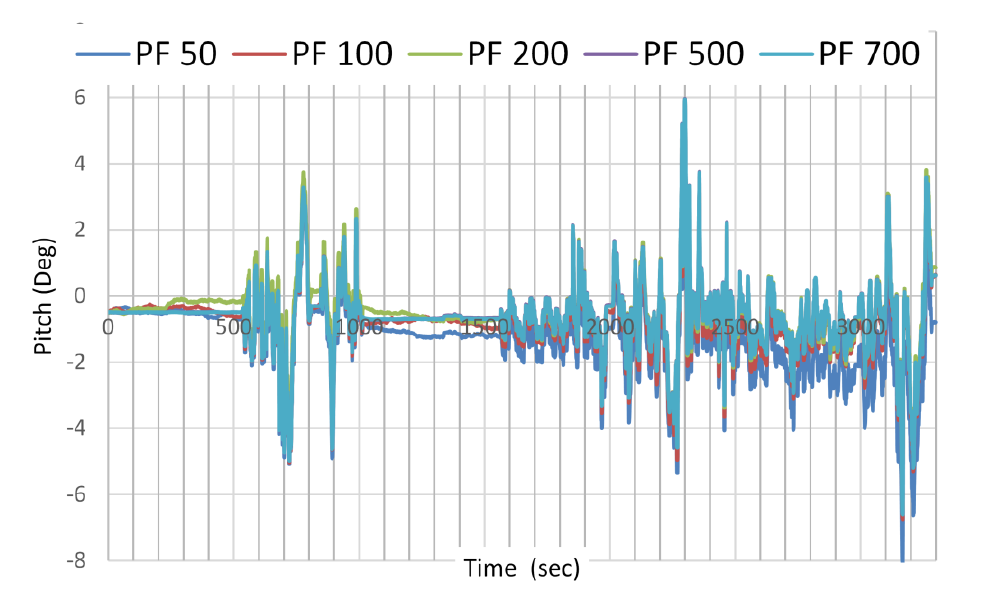
Figure 8. Pitch angle estimation as a function of number of samples used by PF.